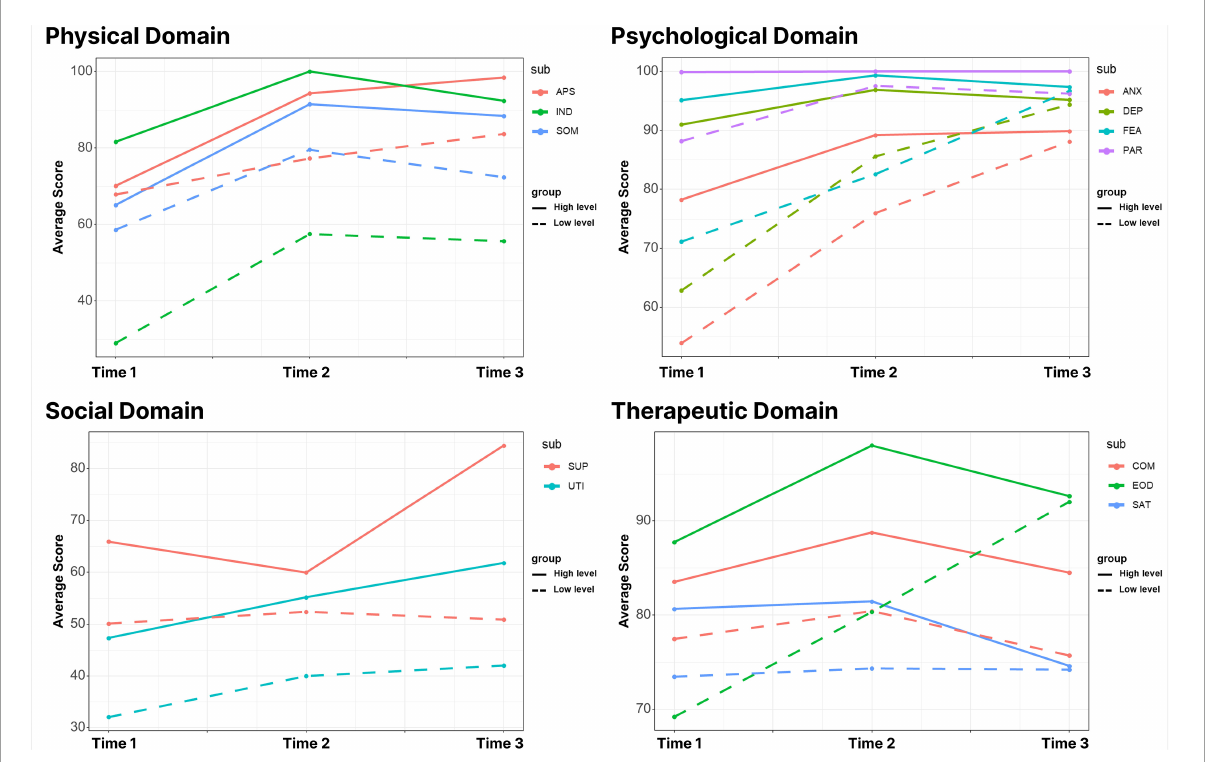
FIGURE2 The average score distribution of people in different dimensions in the four domains of latent transition analysis (LTA). In the four domains, the mean distribution characteristics of the two subgroups at different time points after three potential shifts of dichotomy in different dimensions. SOM, somatic symptoms; APS, appetite symptoms; IND, independence; ANX, anxiety; DEP, depression; FEA, fear; PAR, paranoid; SUP, social support; UTI, support utilization; COM, compliance; SAT, satisfaction; EOD, side effects of